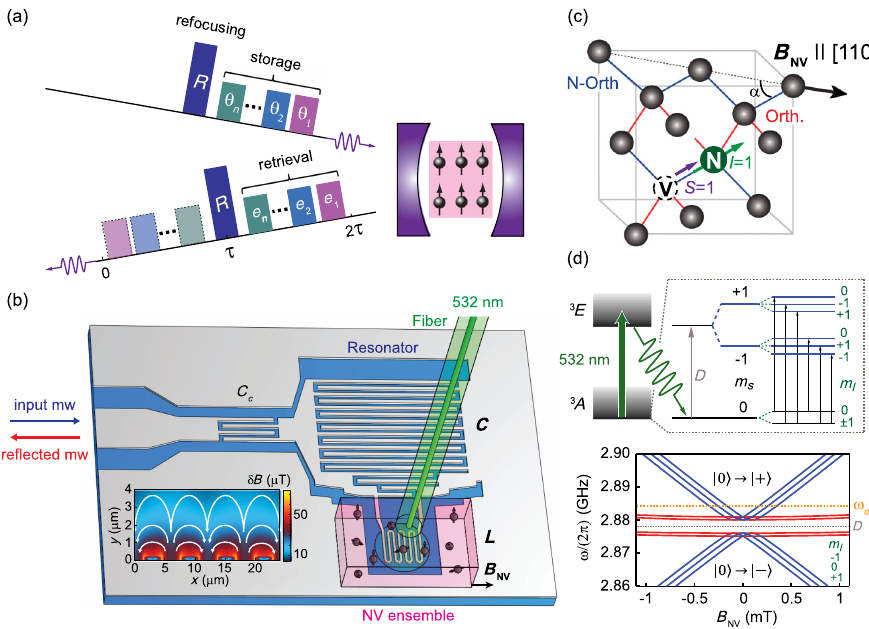
FIG. 1. Principle of the experiment. (a) Scheme of the multimode two-pulse echo (2PE) protocol applied to an ensemble of spins placed in an electromagnetic cavity: successive low-power microwave pulses θ i are stored in the spin ensemble. A refocusing pulse R acts as time reversal for the spins and triggers the retrieval of the stored pulses as echoes e i in reverse order. Top and bottom time lines show the applied and the reflected and echo signals, respectively. (b) Setup placed in a dilution refrigerator: the cavity is a lumped- element parallel LC resonator in niobium coupled to a coplanar waveguide by a capacitor C c . It consists of an interdigitated capacitor C and a meander wire inductor L creating the ac magnetic field shown in the inset, for a 10 μ W incident microwave power at resonance. The spin ensemble consists of NV centers in a diamond monocrystal pressed on top of the inductor. Laser pulses can be shone on it through an optical fiber glued to its top face. A tunable dc magnetic field B is applied parallel to the [110] direction of the crystal. NV (c) Negatively charged NV centers in diamond consist of a nitrogen atom next to a vacancy of the diamond lattice, having trapped an electron. Their electronic spin S ¼ 1 is coupled by hyperfine interaction to the nitrogen nuclear spin I ¼ 1 (for the 14 N isotope). Half of the electronic spins (subensemble denoted N-Orth. in blue) make an angle α ¼ 35 . 3 ° with B , whereas the other half (subensemble NV Orth. in red) is orthogonal to the field. (d) NV simplified energy diagram (top) showing the ground 3 A and the excited 3 E electronic states as well as the Zeeman and hyperfine structure of 3 A , with D= 2 π ¼ 2 . 8775 GHz the zero-field splitting. (bottom) Magnetic field dependence of the allowed transitions for both N-Orth. (blue) and Orth. (red) subensembles, showing, respectively, a linear and a quadratic Zeeman effect. NVs can be optically repumped in their m S ¼ 0 ground state by application of green (532 nm) laser pulses exciting the 3 A - 3 E